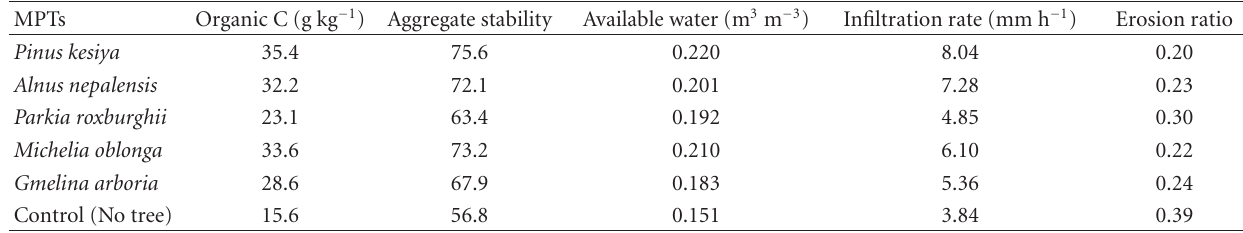
Table 2: E ff ect of various MPTs on soil physical